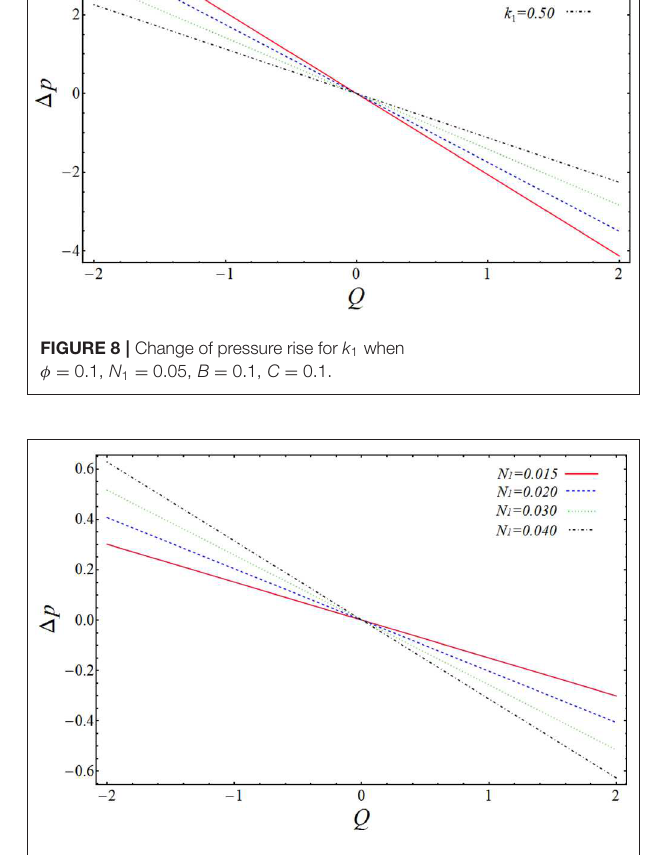
FIGURE 9 | Change of pressure rise for N 1 when φ = 0.1, k 1 = 1, B = 0.1, C =